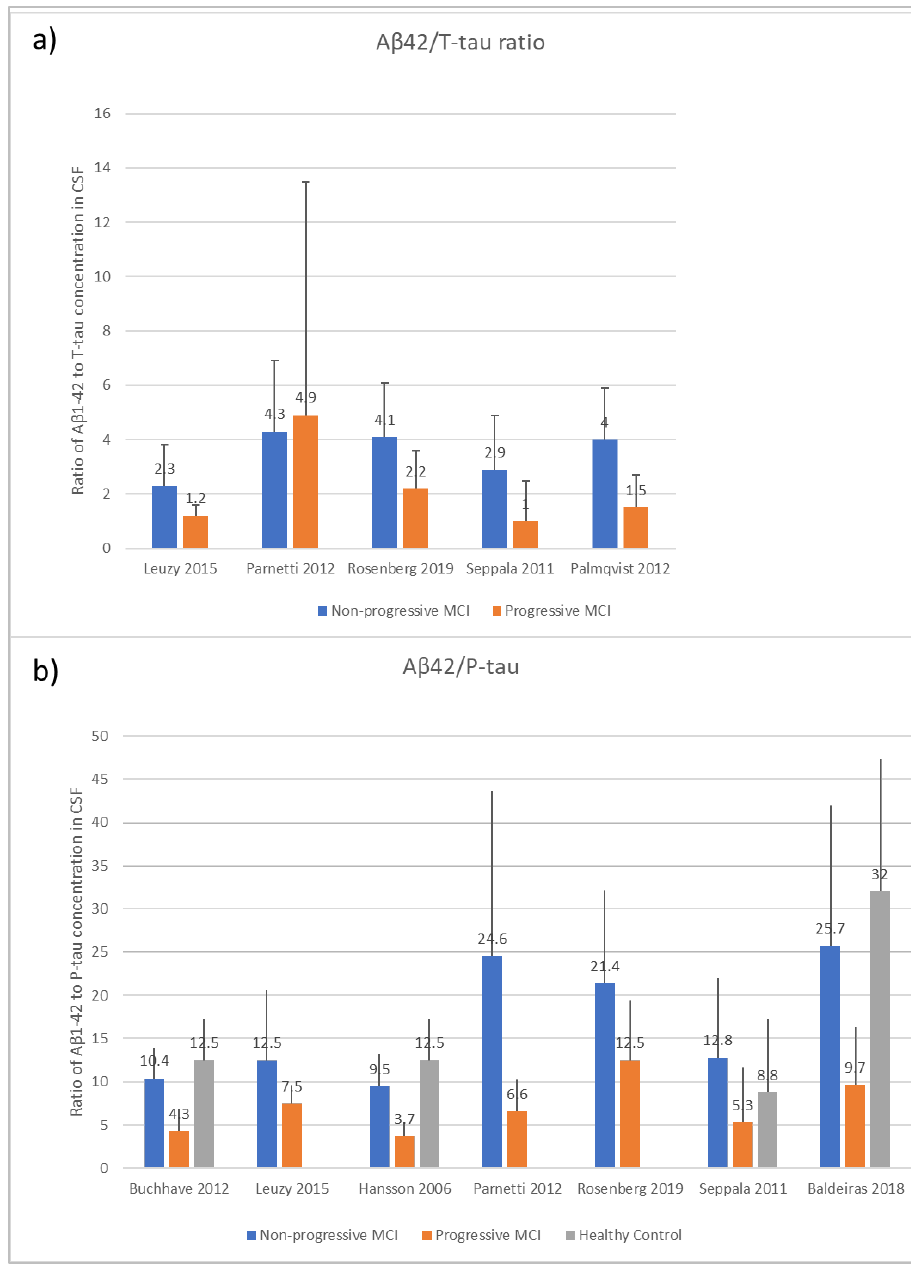
Figure 6. The ratio of Aβ1 -42 to ( a ) T-tau and ( b ) P-tau in CSF, using data for mean and standard deviation (upper bound shown as error bar) taken directly from the sub-set of papers in the systematic review that included this information [32,37,44,48,54,55,57,61].